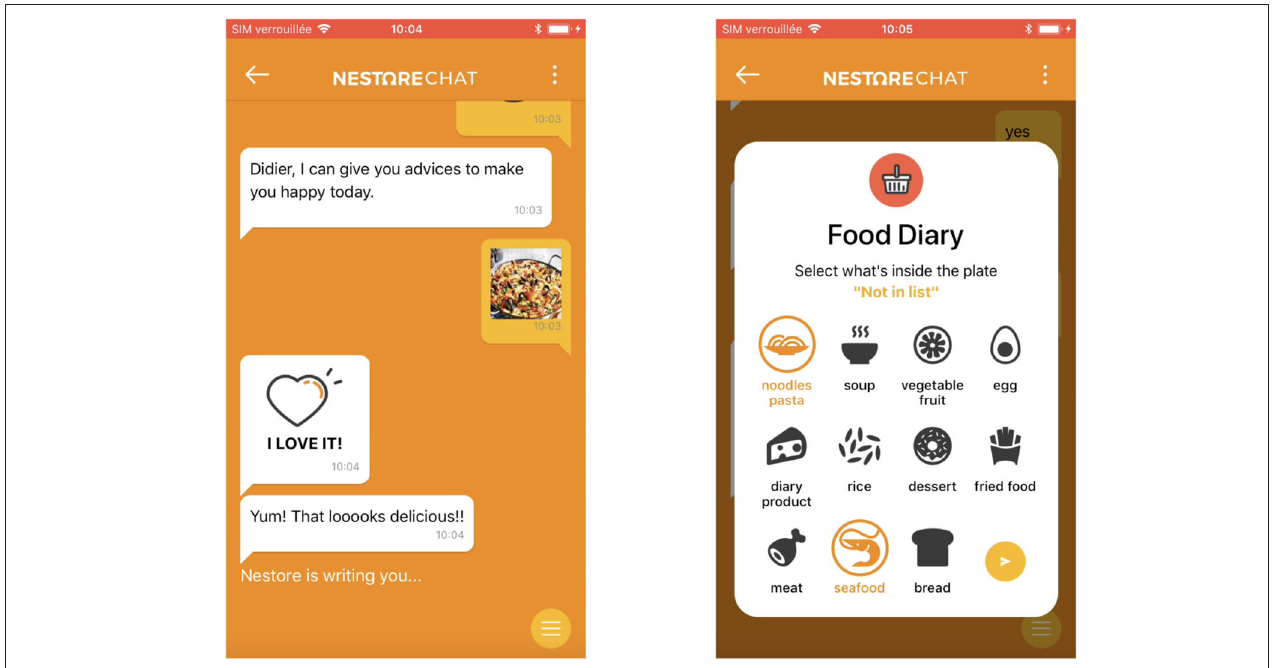
FIGURE 10 | Meal logging via the chatbot